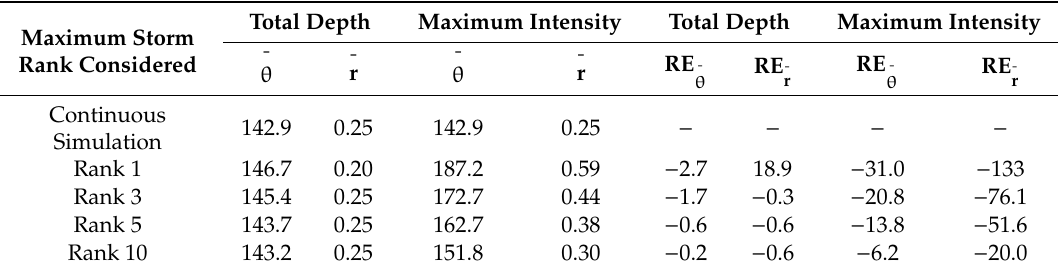
Table 4. Seasonality of the maximum annual volume represented by the angle of its mean direction ( θ ) and its radio (r ), for di ff erent storm ranks and for the two di ff erent criteria studied. The relative error (RE) is also